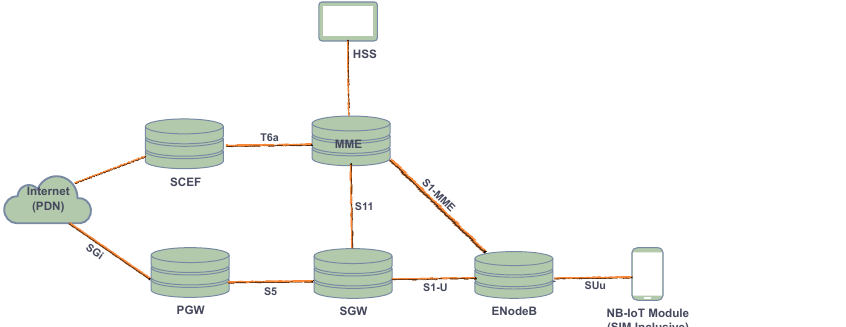
Figure 4. Internal Data Transmission in NB-IoT Network.